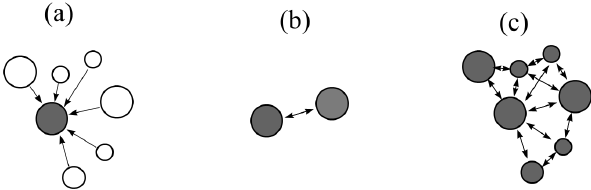
Figure 1. Schemes for (a) individual abrasion (Firey, 1974; Bloore, 1977), (b) binary abrasion (Domokos and Gibbons, 2018), and (c) collective abrasion. Volume loss only tracked for shaded parti- cles. Arrows represent (non-simultaneous) collision events between